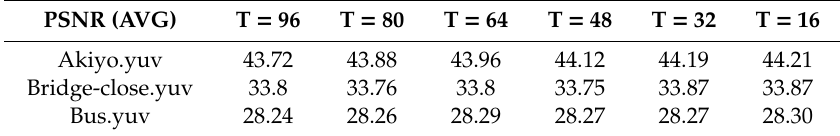
Table 3. Video quality experimental results.